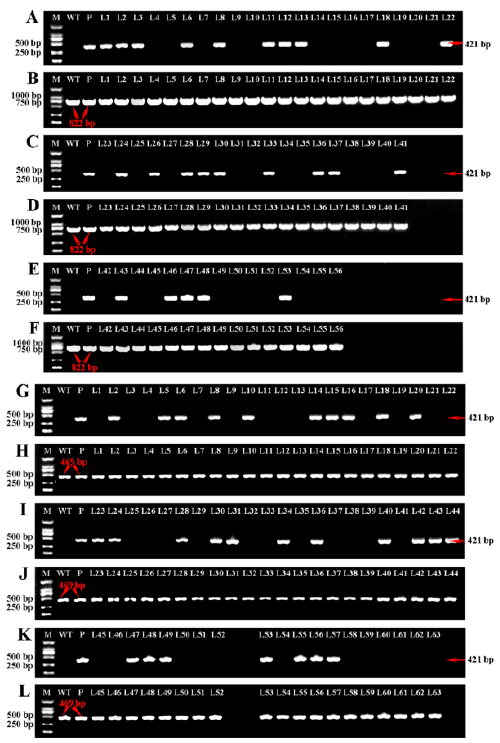
Figure 6. PCR identification of KO- LpABCB21 ( A – F ) and KO- LpPILS7 ( G – L ) positive plants. ( A , C , E , G , I ) and ( K ) are the cloning results obtained using the primers against the OsU3 promoter and sgRNA expression cassette (421 bp). ( B , D ) and ( F ) are the cloning results of the fragments on LpABCB21 containing dual sgRNA (822 bp). ( H , J ) and ( L ) are the cloning results of the fragments on LpPILS7 containing dual sgRNA (469 bp). L42–L56 in ( E , F ) and L53–L63 in ( K , L ) are obtained before the improvement. The other lines are obtained after the improvement. M, 2 kb DNA marker. WT, wild-type plant. P, vector plasmid control.